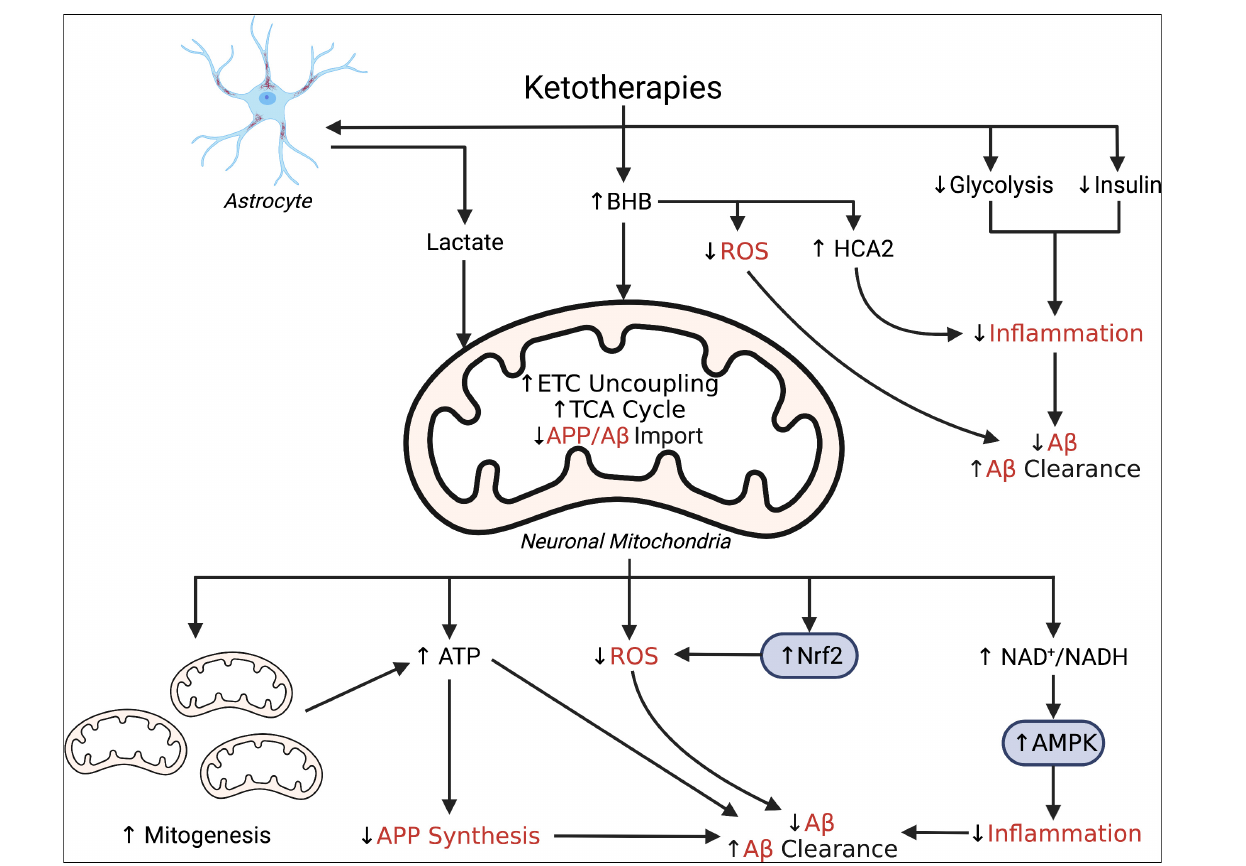
FIGURE 1 | Simplified schematic illustrating putative pleiotropic effects of ketotherapies as modulators of amyloid- β . Ketotherapies (KTs) potentially modulate amyloid- β (A β ) through various direct and indirect mechanisms targeting poor mitochondrial bioenergetics, increased ROS, and increased inflammation. KTs, especially the ketogenic diet (KD), reduce systemic insulin and potentially improve peripheral metabolic status which may improve systemic inflammation and reduce A β . The ketone body, β -hydroxybutyrate (BHB), serves as an energy substrate for mitochondrial metabolism, upregulates the astrocyte-neuron lactate shuttle, activates hydrocarboxylic acid receptor 2 (HCA2) to regulate inflammation, and may directly scavenge reactive oxygen species (ROS). Through bioenergetic effects in the mitochondria, KTs stimulate genesis of new mitochondria, increase uncoupling of the electron transport chain (ETC) to increase ATP production, generate less ROS than glucose metabolism, and reduce mitochondrial import of amyloid precursor protein (APP) and A β . KTs also activate nuclear factor-E2 related factor 2 (Nrf2) to upregulate synthesis of ROS-scavenging antioxidants and AMP-activated protein kinase (AMPK) to regulate transcription of pro-inflammatory cytokines. This figure created with BioRender